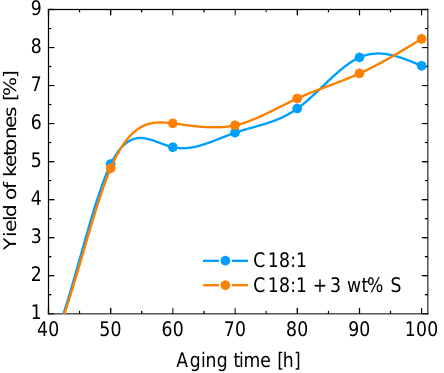
Figure 15. Development of 9-oxooctadecanoate over aging time. The progress of ketones was determined for C18:1 (blue) and C18:1 + 3 wt% S (orange) ( n = 2).